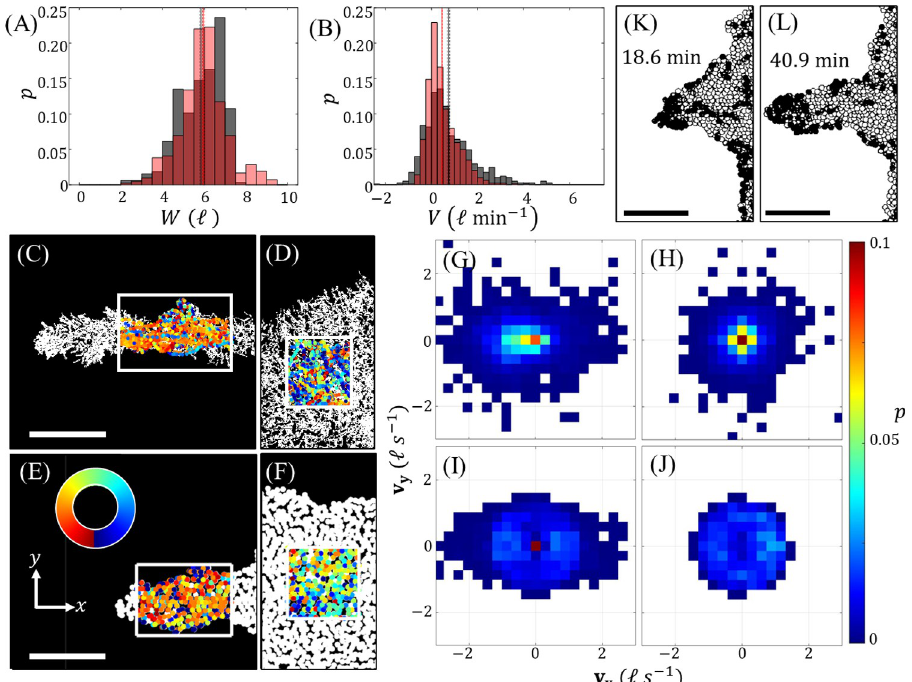
Fig 4. Comparing Protrusion Dynamics. (A-B) Probability mass functions are shown for ( A ) the average protrusion widths, W , and ( B ) growths rates, V of more than 400 experimental observations (grey) and numerical observations (light red) each. Here, R = 0.9 ℓ , η = 0.2 and A 2 ½ 1 : 25 ; 1 : 47 � . (C-D) The direction of motion of free ants on experimental sections of ( C ) a protrusion and ( D ) the bulk of a raft are visually illustrated with the color of a free agent representing its direction of travel during one frame-to-frame observation. (E-F) The same visual analysis is made for sections of ( E ) a protrusion and ( F ) the bulk of a simulated raft, where the direction of travel is measured between one timestep. (C-F) Colors are assigned according to orientation based on the color wheel depicted in ( E ). ( G-J ) 2D velocity distributions are shown, courtesy of Wagner, et al. (2021) [14]. ( G-H ) correspond to ( C-D ), respectively, while ( I-J ) are the ensembled results from 11 in silico protrusions and on the order of 100,000 discrete velocity observations, each. A simulated protrusion at the start (K) and end (L) of a roughly 21 min duration exhibits how directional motion on protrusions culminates in clustering of freely active agents (black circles) at the tip and rapid, anisotropic growth. (A-B,C-D,G-H) Experimental results are courtesy of Wagner, et al. (2021) [14]. Scale bars in ( C,E,K,L ) represent 10 ℓ . All simulated rafts were initiated as circles such that the in silico protrusion growths depicted (and from which data were collected) occurred stochastically.